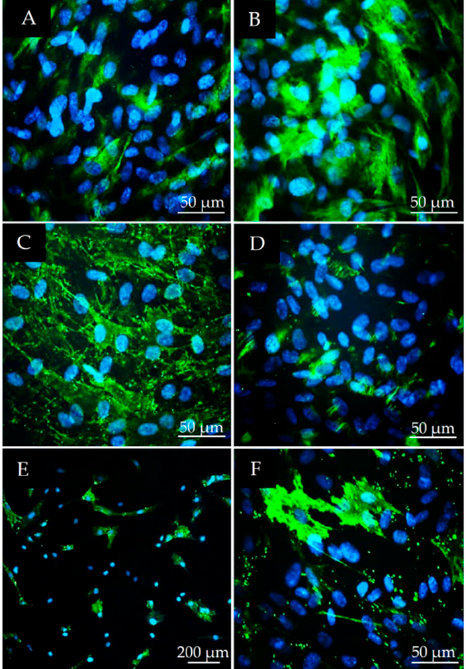
Figure 2. Immunofluorescent detection of the following mesenchymal and stem cell markers in DPSC cultures (passage 3): nestin ( A ), vimentin ( B ), CD90 ( C ), c-kit/CD117 ( D ), STRO-1 ( E , F ). The scale bars indicate 50 µ m ( A – D , F ) and 200 µ m ( E ). Green fluorescence shows specific immunostaining (Alexa Fluor 488) while blue shows the cell nuclei